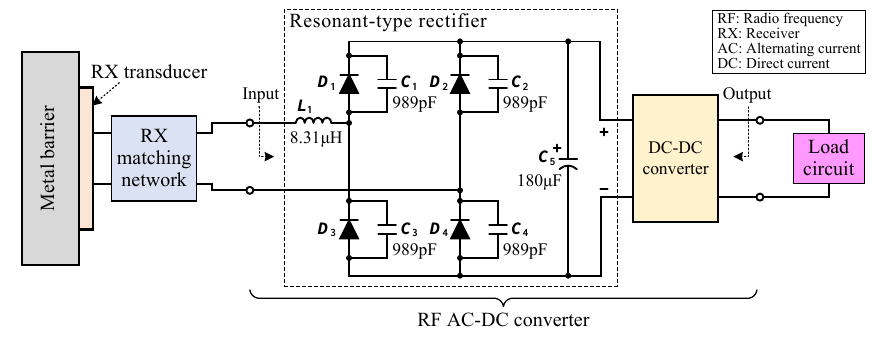
Figure 8. Schematic of the RF AC-DC converter used in the